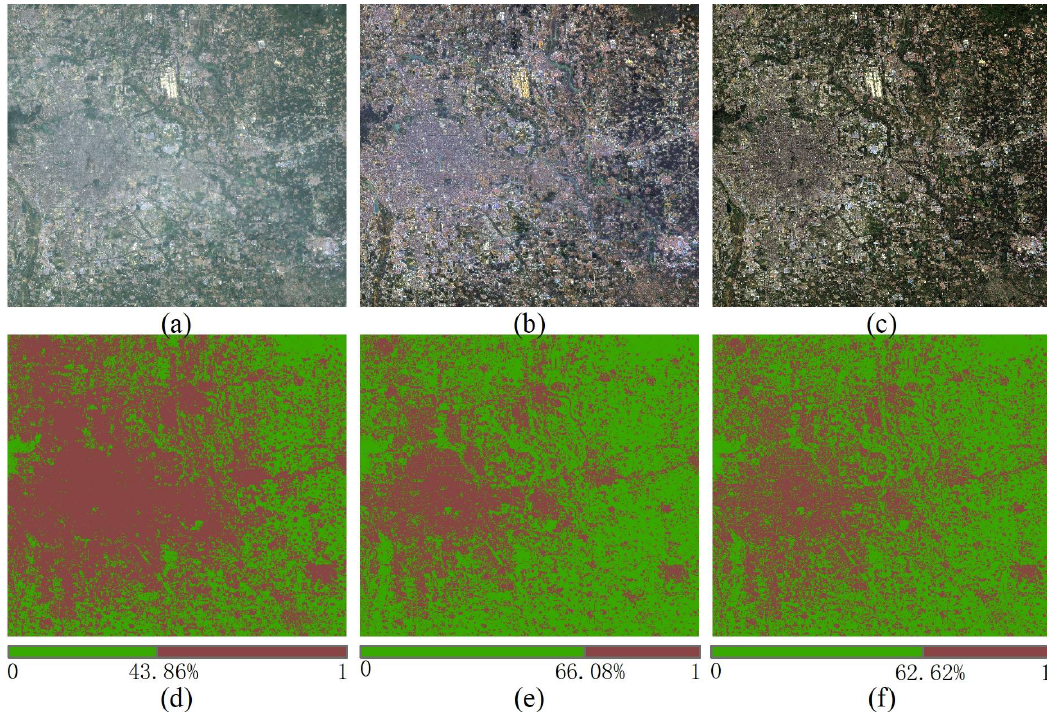
Figure 19. Atmospheric correction of dehazing results: ( a ) hazy image (path: 123, row: 032, acquisition date: 19 August 2014); ( b ) dehazed image using MODEL-T; ( c ) haze-free image (path: 123, row: 032, acquisition date: 4 September 2014); ( d – f ) classification results of a-c respectively; the green represents pixels whose NDVI are equal to or larger than 0.5; the brown represents pixels whose NDVI are smaller than 0.5; the numbers at the bottom indicate the percentage of vegetation.